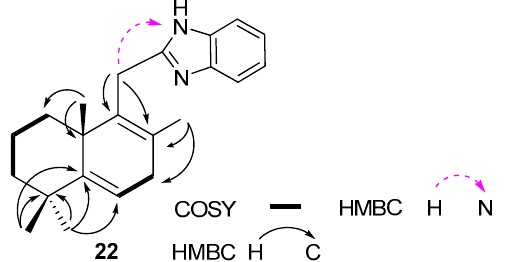
Figure 4. Selected COSY and HMBC correlation for compound 22